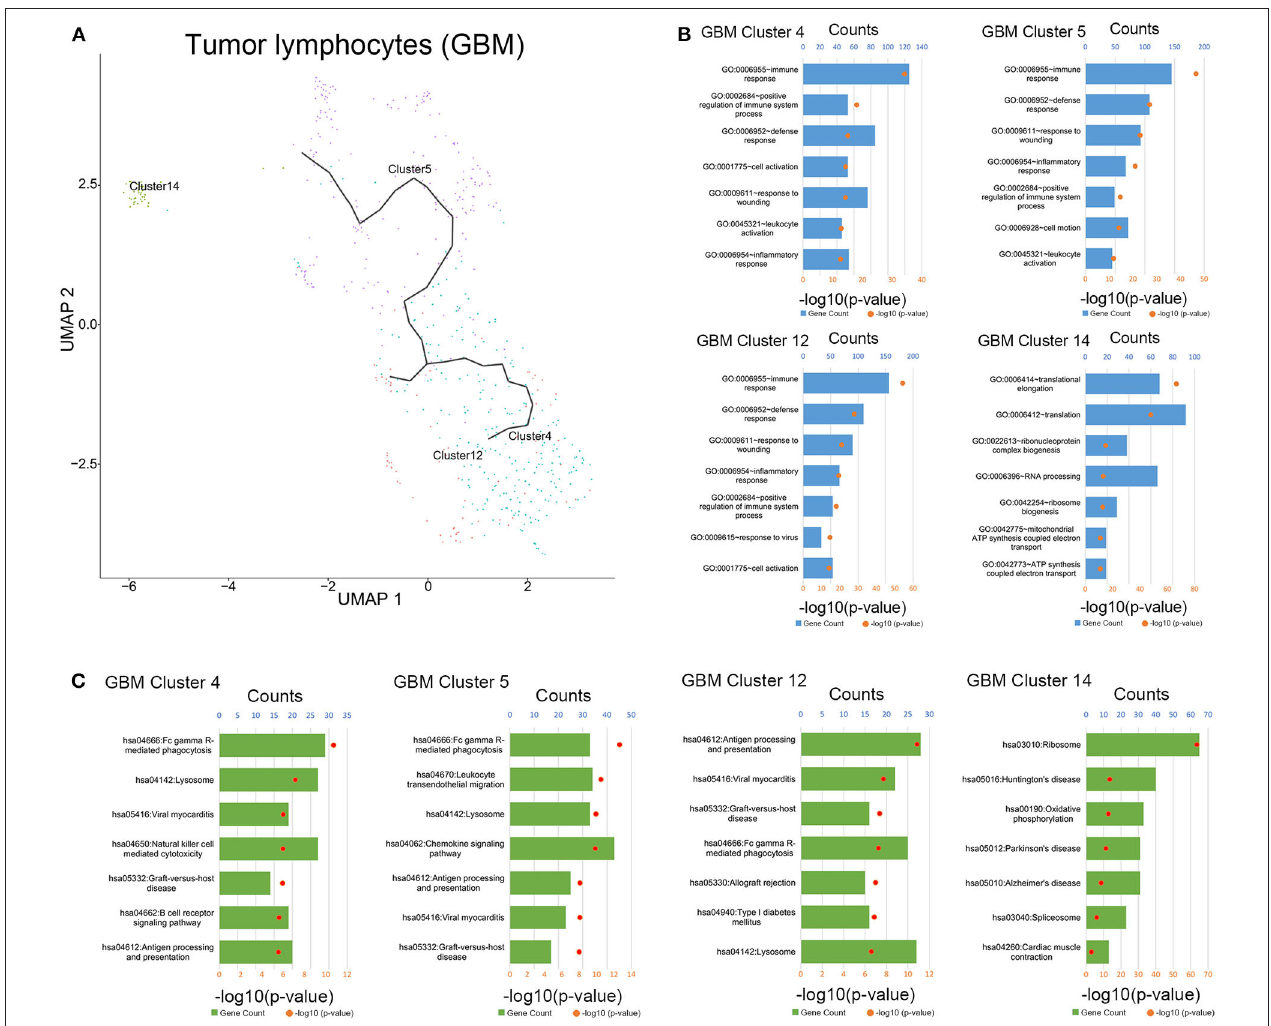
FIGURE 5 | Evolution routine and function enrichment of lymphocytes in surgical specimens. (A) The evolution direction of lymphocytes in surgical specimens. (B) Enrichment analysis of biological functions for lymphocytes in the surgical specimens. (C) Pathway enrichment analysis for lymphocytes in the surgical